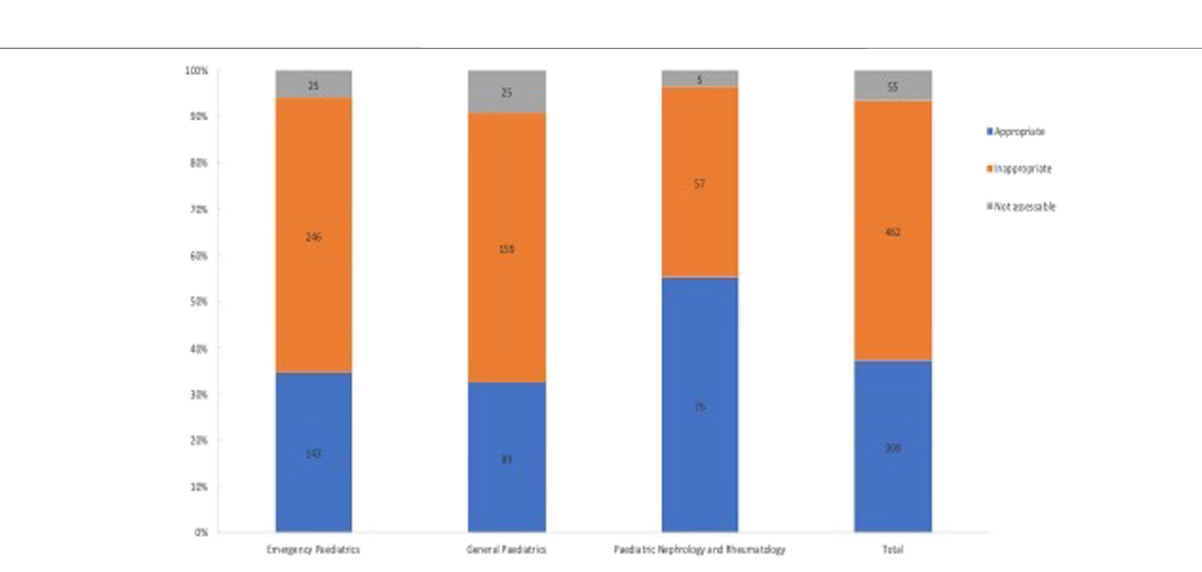
Frontiers in Pharmacology |